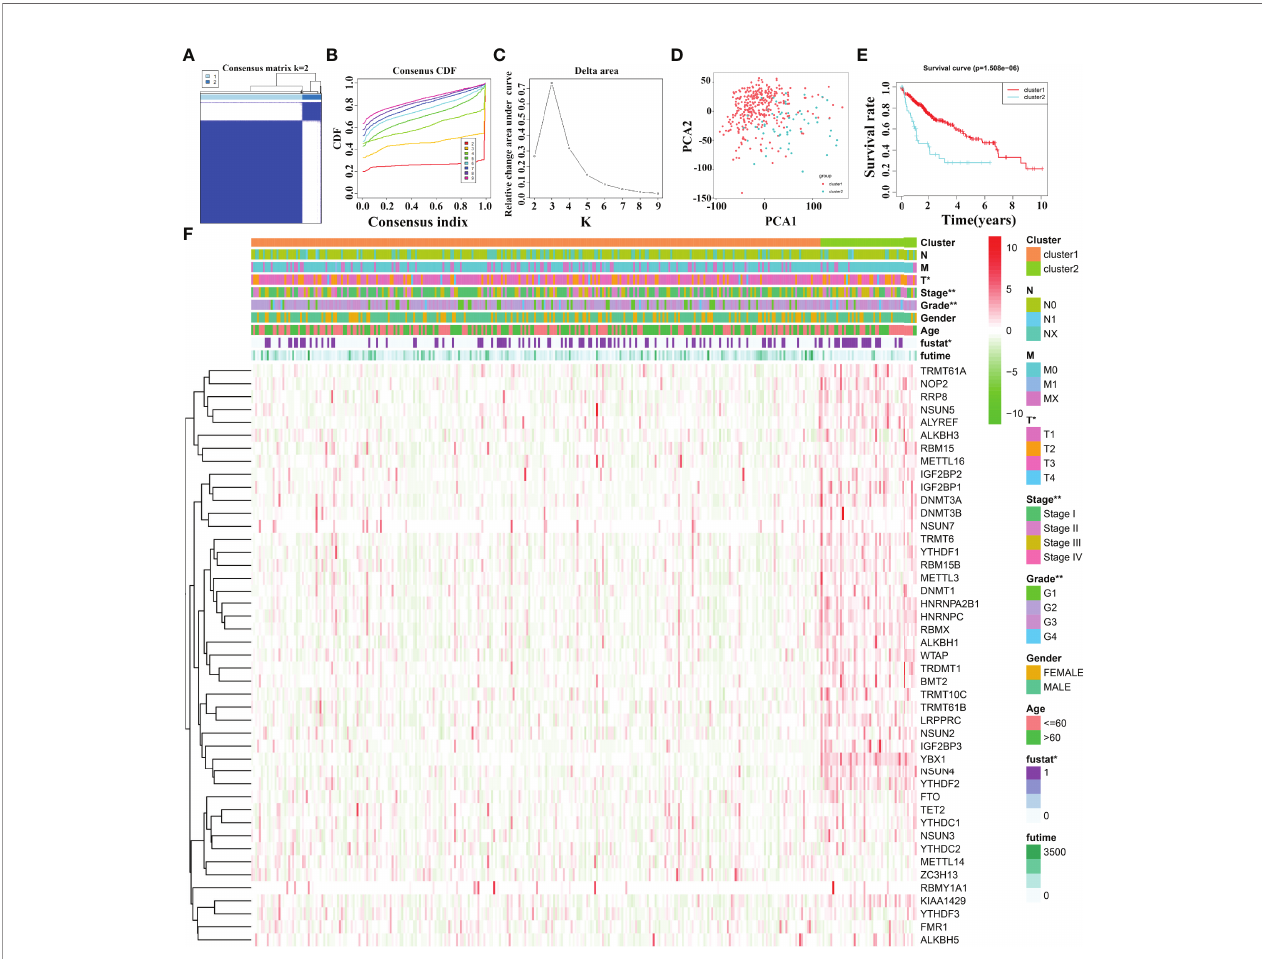
FIGURE 2 | The clinical values in m6A/m1A/m5C regulated gene subgroups in HCC patients based on consensus clustering. (A – C) The consensus clustering of m6A/m1A/m5C regulated genes. (D) PCA. (E) K-M survival analysis. (F) The relationships between the clinicopathological features and m6A/m1A/m5C regulated gene subgroups. HCC, hepatocellular carcinoma; PCA, principal component analysis; K-M, Kaplan – Meier; *P < 0.05; **P <